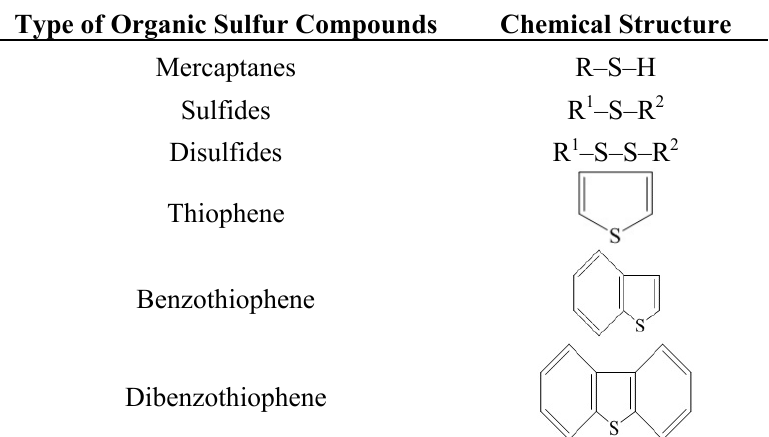
Table 4. Typical organosulfur compounds in heavy oil